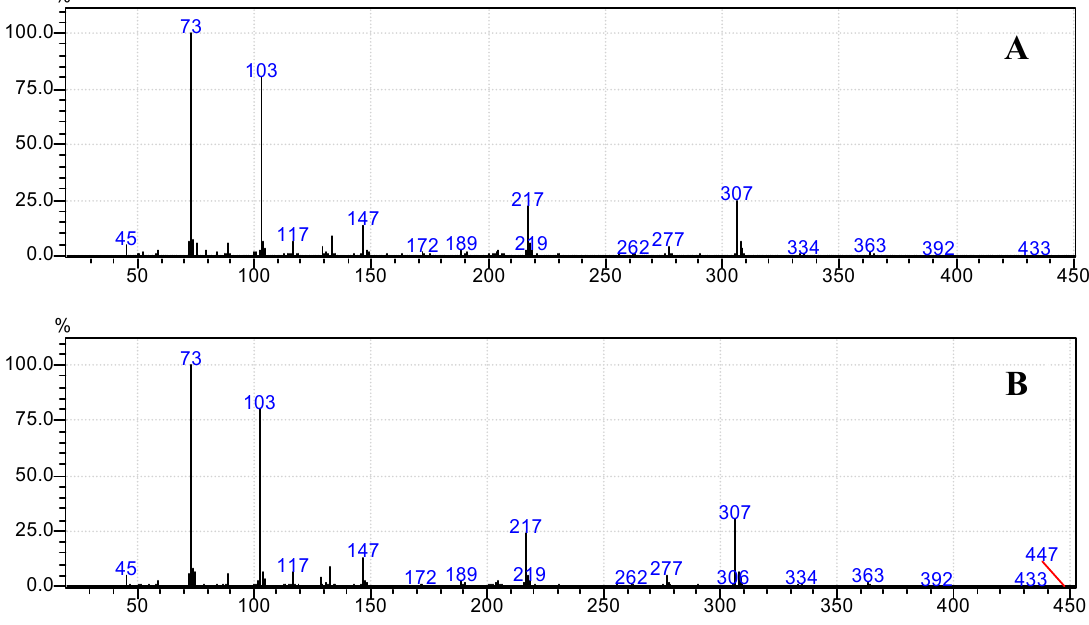
Figure 6. Mass spectrum at a retention time of 3.88 min. ( A ) Standard fructose; ( B ) Date juice.